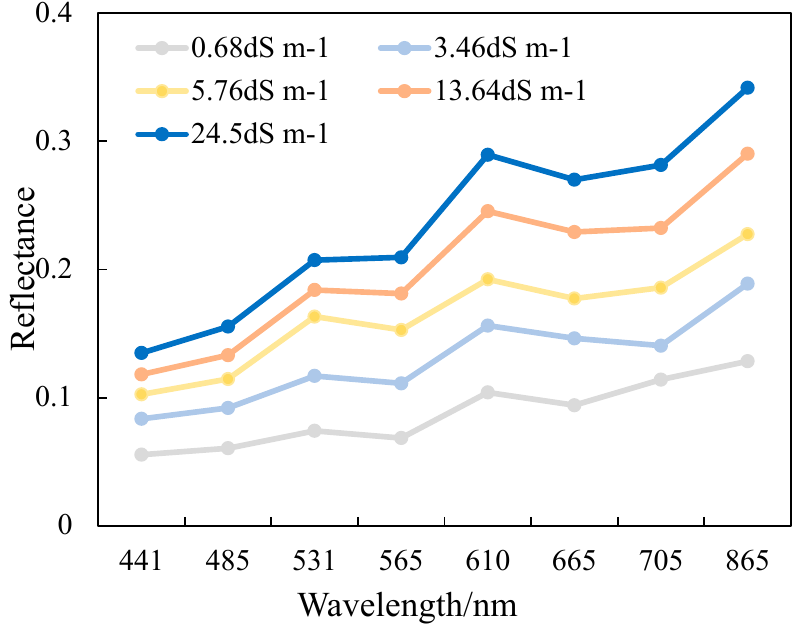
Figure 3. Reflectance spectra curves of soils with different electrical conductivity (EC) values in the study area.